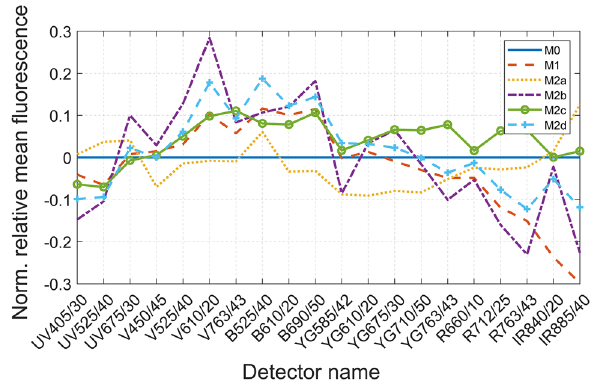
Figure 4. Comparison of the mean fluorescence intensity plot for the pulse height across the six phenotypes. This represents the same data in Fig. 3, however the intensities are normalized to M0 phenotype. The naming convention of the detectors is C (cid:31)(cid:31)(cid:31) /ββ , where C represents the laser color, (cid:31)(cid:31)(cid:31) represents the detector’s wavelength, and ββ represents the detector’s bandwidth (measured in